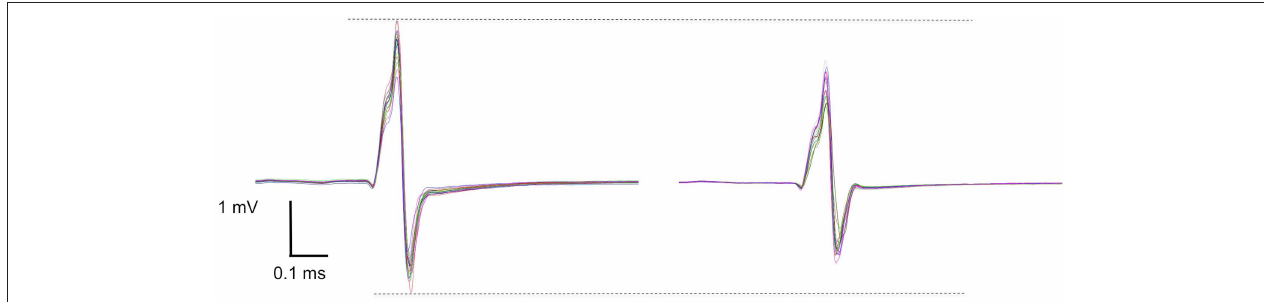
FIGURE 2 | A raw data set of one subject shows the effect of before ( left ) and after ( right ) the rPMS. Each graph shows 15 peak-to-peak superimposed compound muscle action potential (CMAP pp ) curves that were induced by a reflex hammer impact on the Achilles tendon. Mean CMAP pp amplitudes were ∼ 4.2mV at baseline and ∼ 3.5mV after the rPMS in this subject.